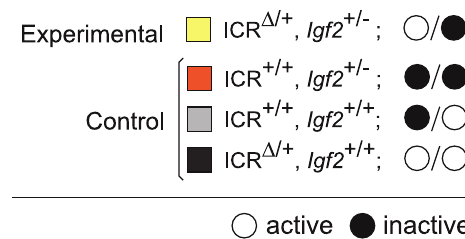
Figure 1. Weight gain in Igf2 mutants carrying ICR D . Young were obtained from (ICR D / + , Igf2 + / + R 6 ICR + / + , Igf2 + / 2 = ) matings. Bars are mean 6 s.d., with (n) given above the 1 wk bars. Key: alleles are maternal/paternal in derivation. The two-sample t -test was used to determine the probability that two 6 week samples (identified as paired squares) were